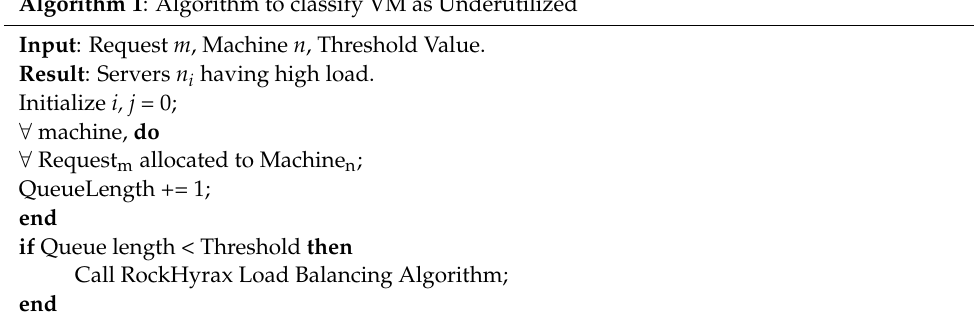
Algorithm 1 : Algorithm to classify VM as